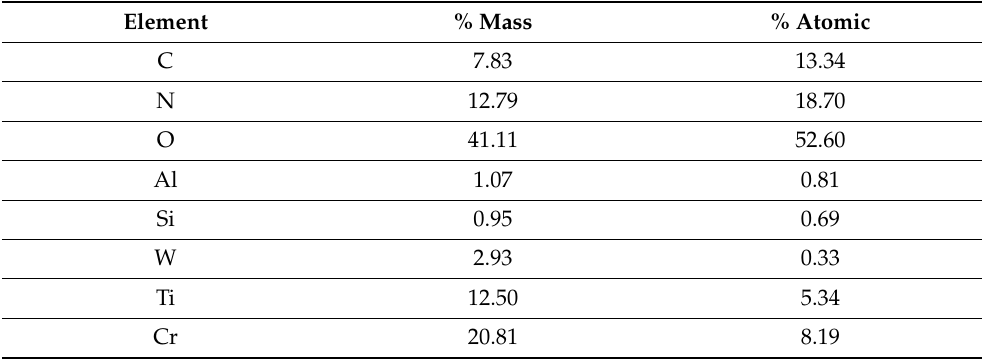
Table 5. Qualitative EDS analysis of zone 1 covering with oxide films and adhesive layers in Figure 17d.